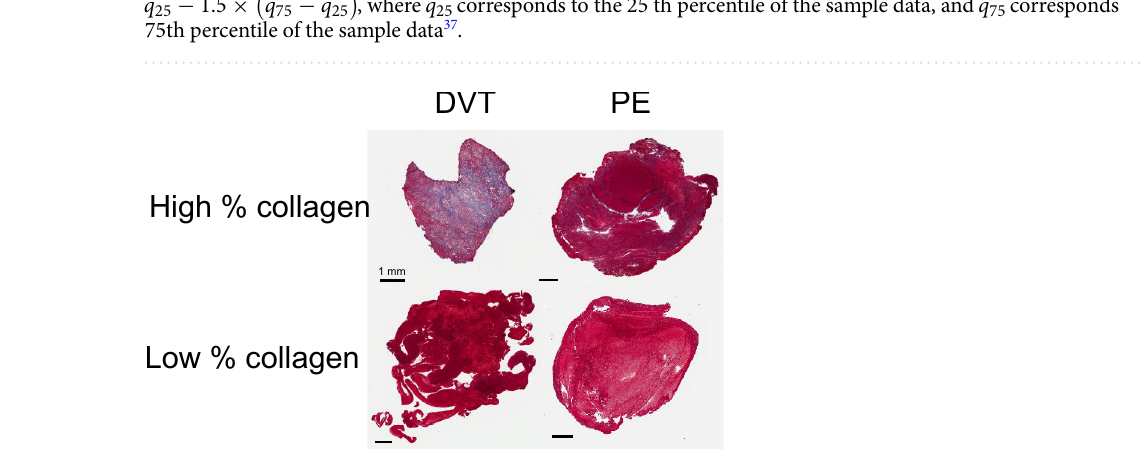
Figure 2. Observed patient-to-patient variability in collagen observed in ex vivo thrombus samples. Deep vein thrombi (DVT) are shown in the left column, pulmonary emboli (PE) are shown in the right column. Collagen appears blue in the Masson’s trichrome stain and compromises 60% (top left) and less than 1% (bottom left) for DVT, and 14% (top right) and less than 1% (bottom right) for PE by area. Colorimetric analysis was conducted in ImageScope (Leica Biosystems, Germany) to identify pixels associated with collagen. Color thresholds were evaluated and accepted by a board-approved pathologist. The scale bars indicate 1